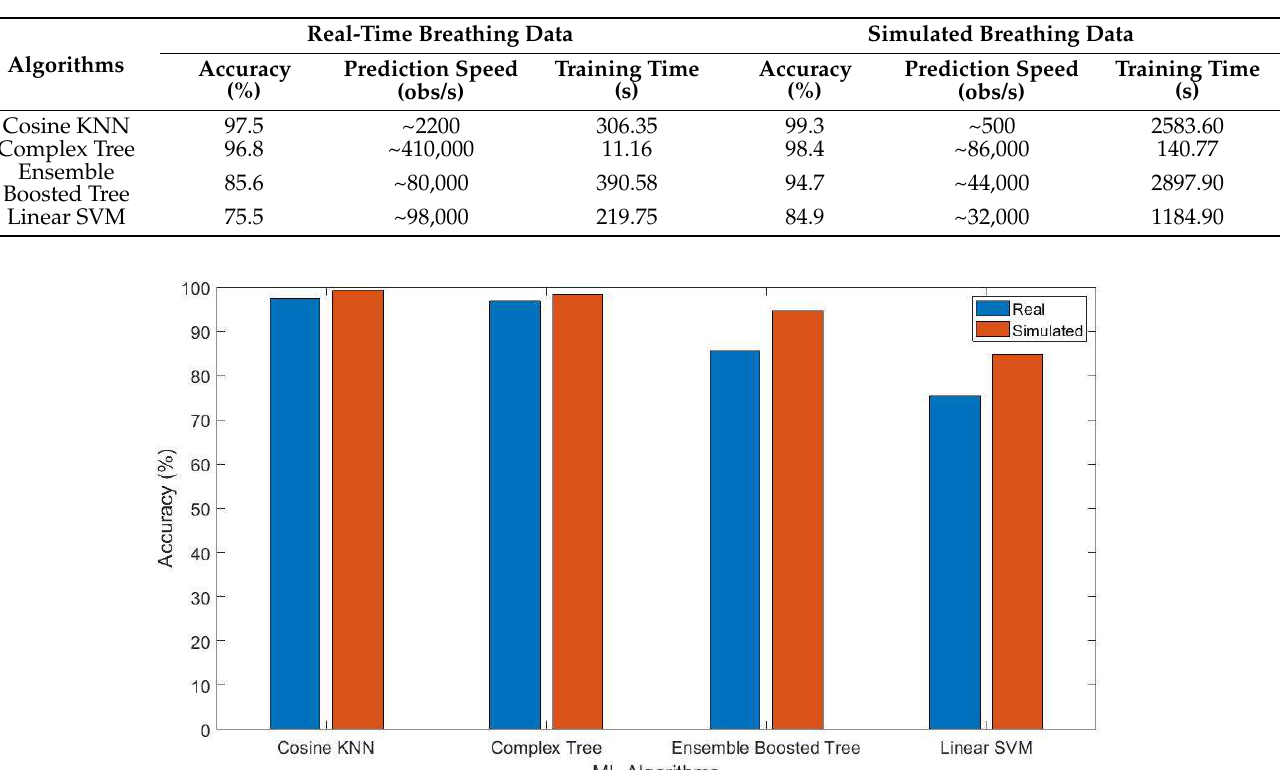
Table 6. Performance of ML algorithms.